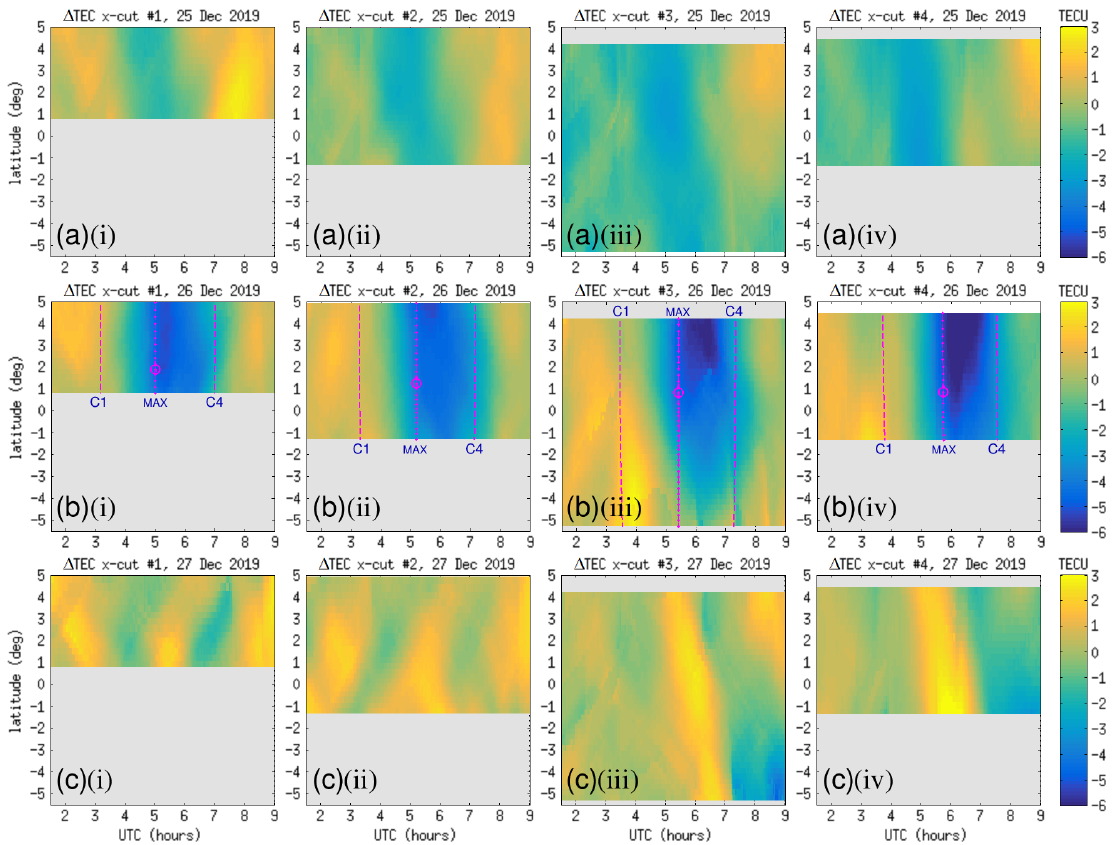
Figure 14. Color-map plots of (cid:49) TEC values as a function of time and latitude along x-cut nos. 1 to 4 on (a) 25, (b) 26, and (c) 27 December 2019. Time intervals are magnified around the solar eclipse on 26 December 2019. The start and end times of the eclipse (C1 and C4) as well as the moment of maximum eclipse are indicated by dashed and dotted curves on the plots. Circles indicate the moment and location of the greatest solar obscuration along each